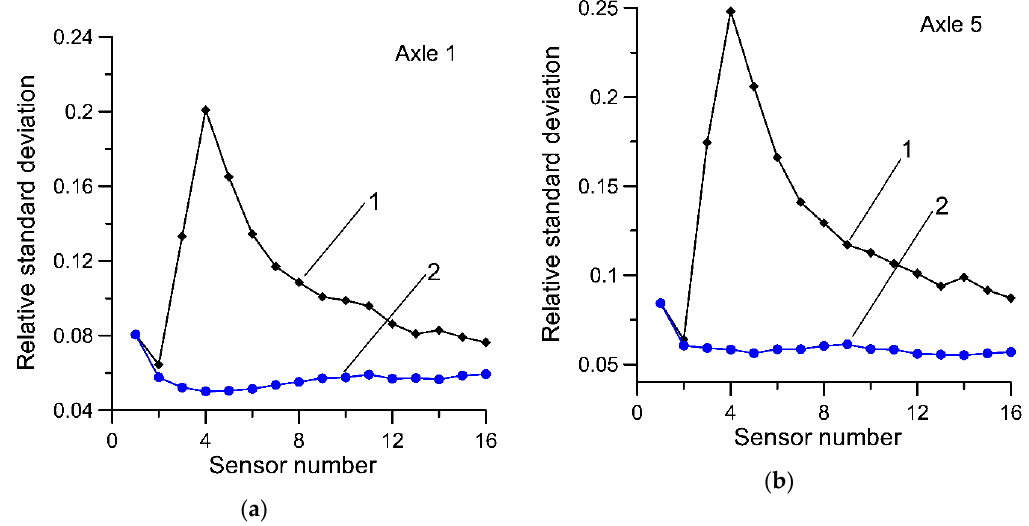
Figure 8. Relative standard deviation of estimates of static axle load, ( a )—axle no. 1; ( b )—axle no. 5; with weighing results from individual sensors averaged in the order in which the sensors were installed at the MS-WIM site. Curve 1—results for Equation (1), curve 2—results for Equation (7).